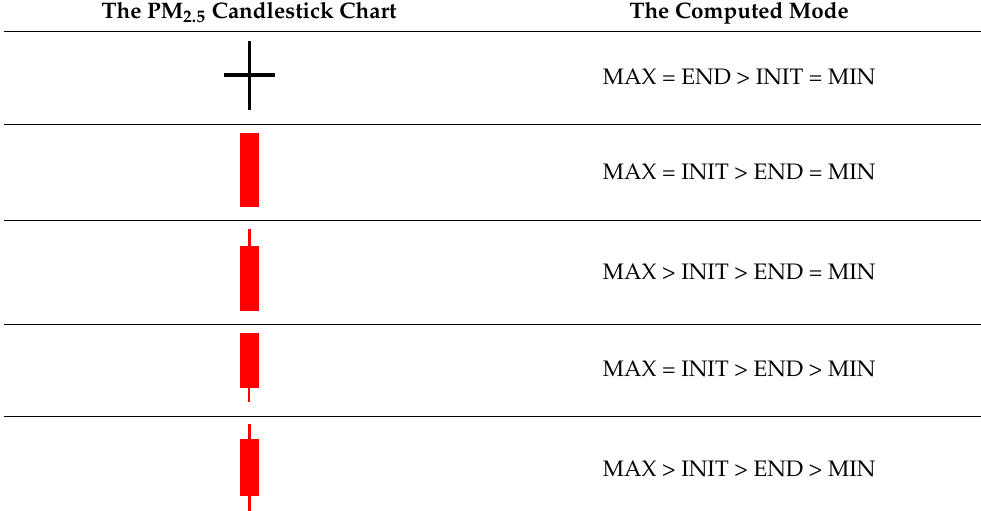
Figure 3. Relationship between the PM 2.5 concentration change at the target point. Assuming that Table 1. Nine basic patterns of the candlestick charts. Q is unchanged, the relationship between the change in v and C is shown in ( a ). Assuming that Q is unchanged, the relationship between the change in d and C is shown in ( b ). Assuming that v and d remain unchanged, the relationship between Q and C is shown in ( c ). Table 1. Nine basic patterns of the candlestick charts.